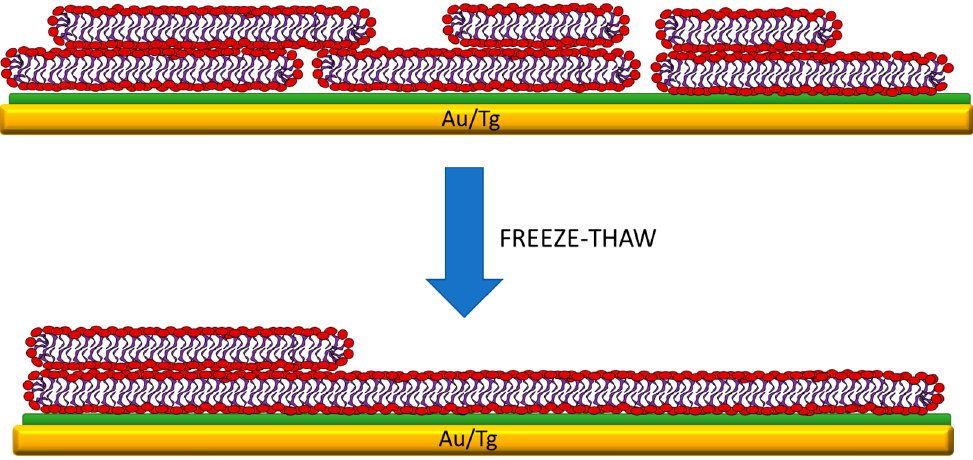
Figure 8. Model illustrating spontaneous deposition of the bicelles on the thioglucose-modified gold electrode and the effect of the freeze–thaw treatment on the structure of the lipid film. Spontaneous deposition of bicelles leads to the formation of a defected double bilayer, but the freeze–thaw treatment causes reorganization of the membrane structure into a defect-free single bilayer with the locally occurring double bilayer.